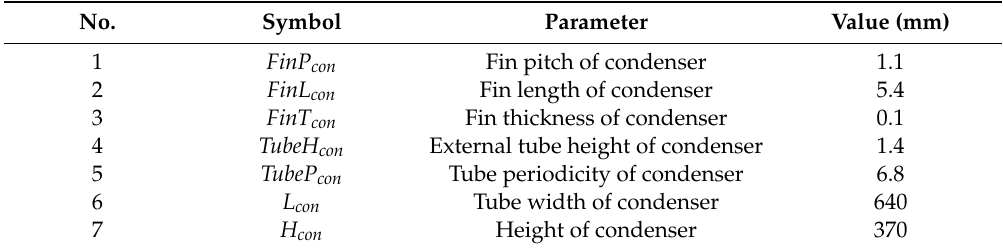
Table 6. Structural parameters of